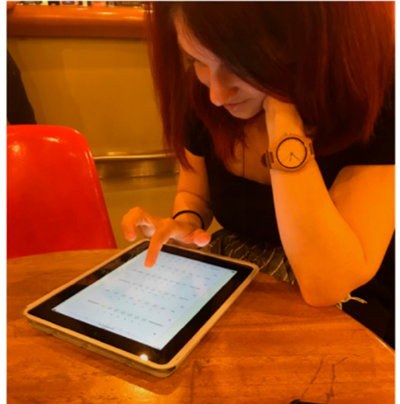
Figure 18. Participant and experimenter during the wayfinding experiment.